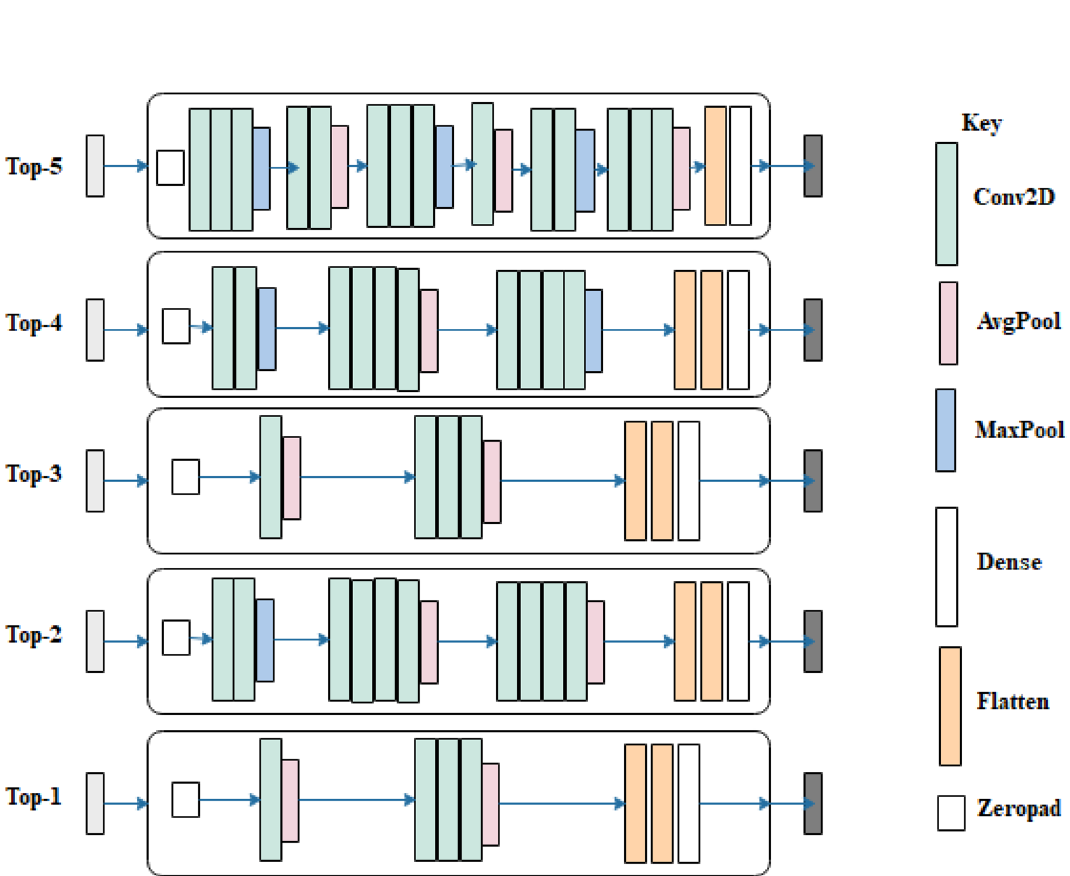
Figure 8. Neural network architectures of the Top-5 generated network architectures generated for the search